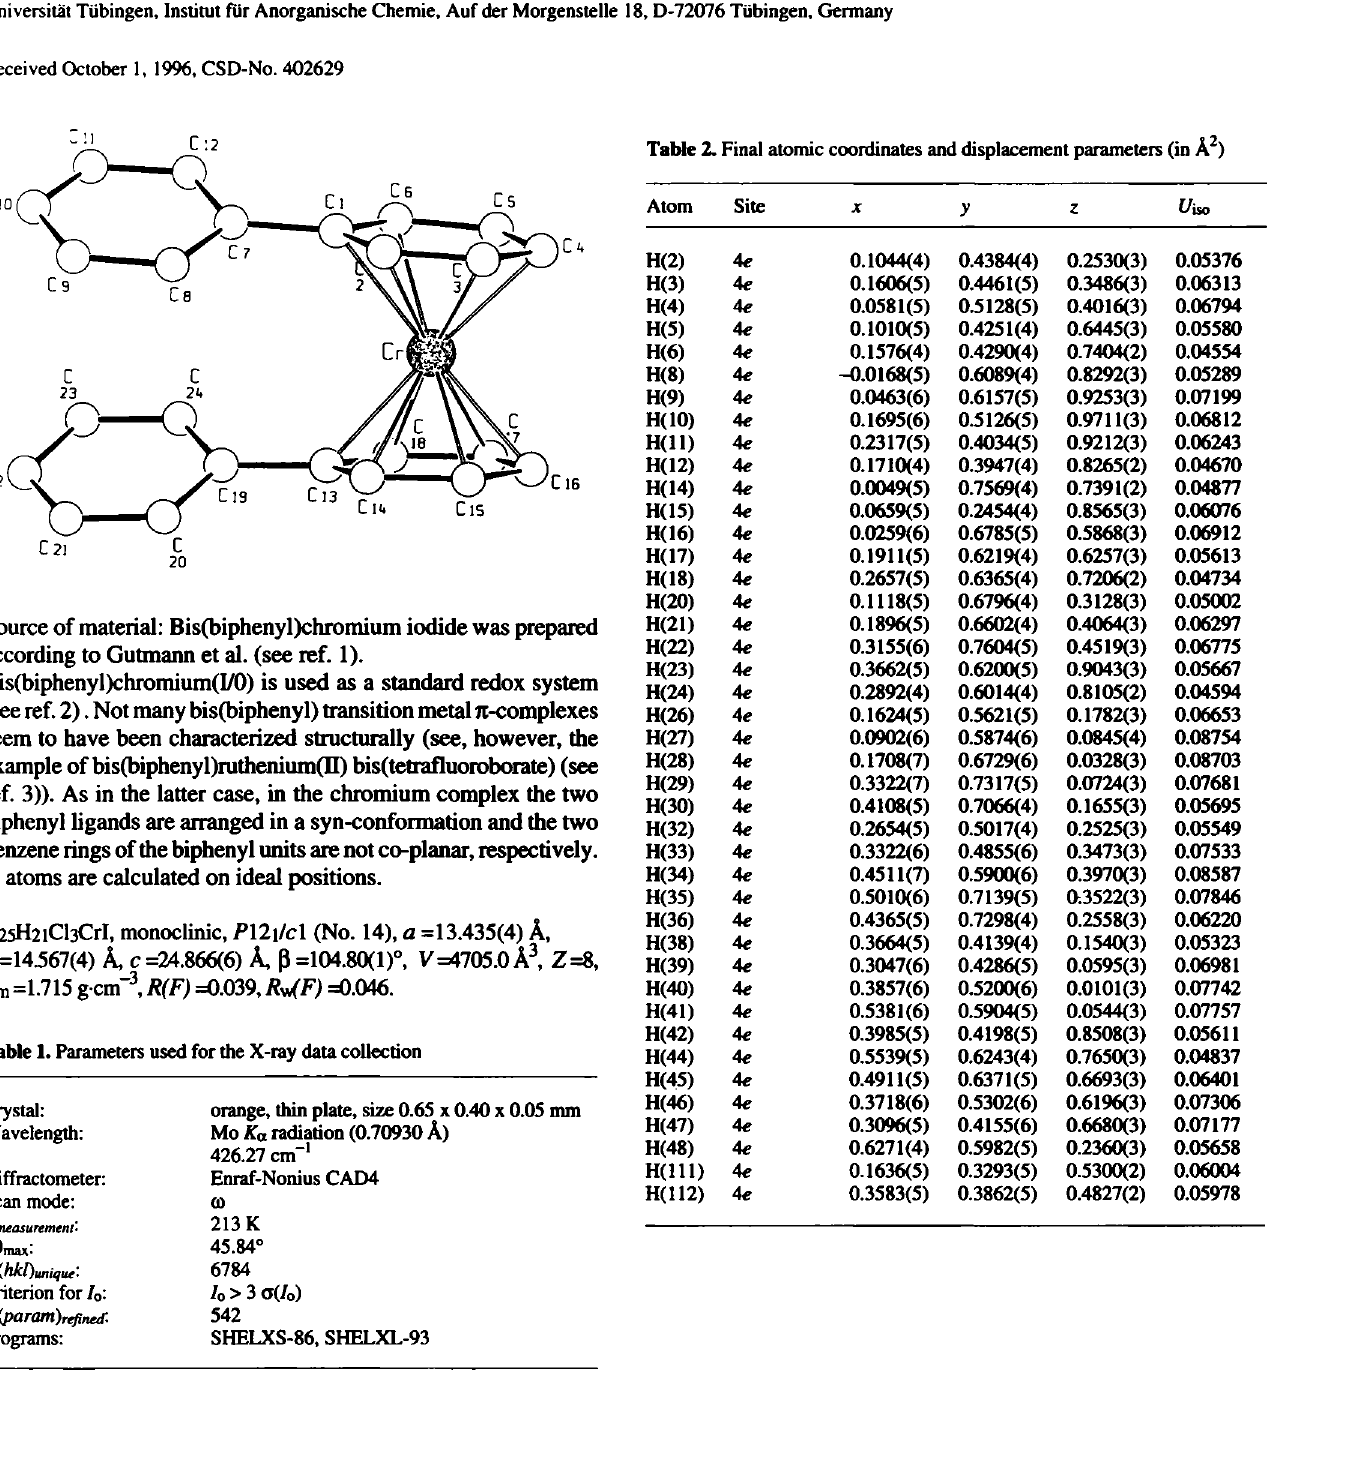
Table 2. Final atomic coordinates and displacement parameters (in Â 2